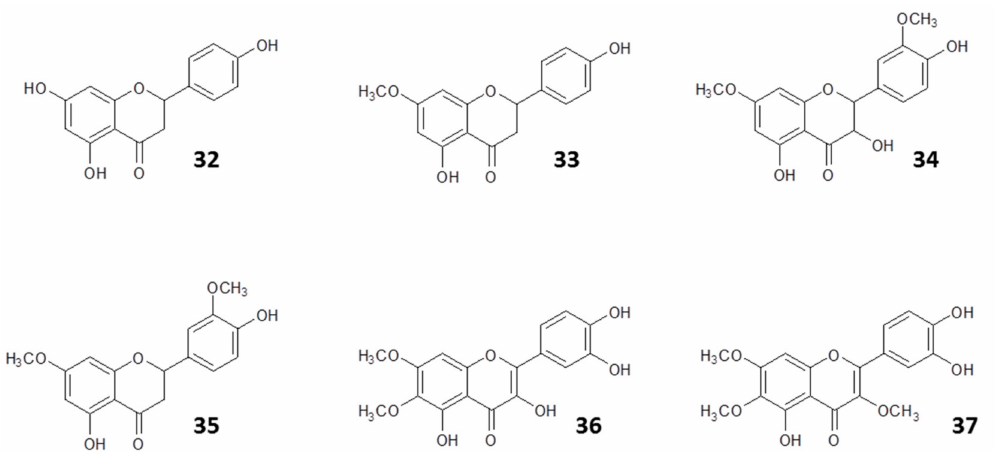
Figure 6. Structures of some flavonoids identified in the active fraction of propolis from Ecuador with antileishmanial activity [63].